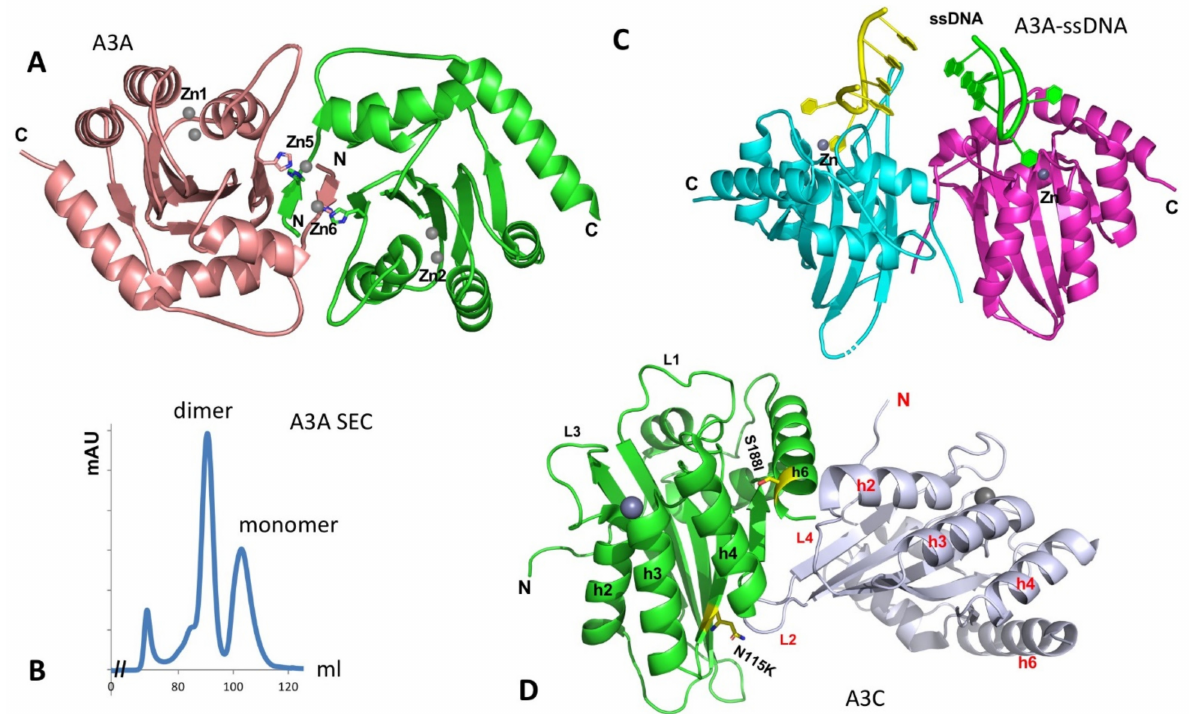
Figure 5. The structure of A3A and the two packed A3C molecules in the crystal asymmetric unit. ( A ) The dimer structure of A3A without binding ssDNA (PDBid: 4XXO). The dimerization is mediated mainly through the N-terminal arm exchange between two subunits (colored in brown and green), which is further cemented by two Zn-atoms (Zn5, Zn6) coordinated by residues from two subunits. The Zn1 and Zn2 are active site Zn-atoms. ( B ) The SEC assay of wildtype A3A purified from E. coli expression system on Superdex 75 at a protein concentration of 2 mg/mL, showing monomer and dimer peaks in a buffer containing 20 mM Tris-HCl, 250 mM NaCl (pH 8.0), 1 mM DTT, and 1 mM EDTA (to be published data). The small peak at the left side is void volume (aggregated A3A protein). No RNA can be detected in any of the peaks. ( C ) The structure of ssDNA-bound A3A as monomer (DPBid: 5KEG, 5SWW) that is superimposed on to the two subunits of the apo dimer structure shown in (A). This superimposition does not show additional interaction of the bound ssDNA at the two Zn-center of each monomer with any residues from the other monomer, suggesting the short ssDNA bound to the active center does not need a dimer. However, these structural data alone cannot exclude the possibility that longer ssDNA binding to one Zn-center can bind to the other monomer to enhance the binding. ( D ) The crystal structure of A3C (PDBid: 3VOW), showing two A3C molecules packed into one asymmetric unit, which has the largest intermolecular contact interface in the crystal packing. The positions of the S188I variant (S188 side chain) and N115K (N115 side chain) are shown in